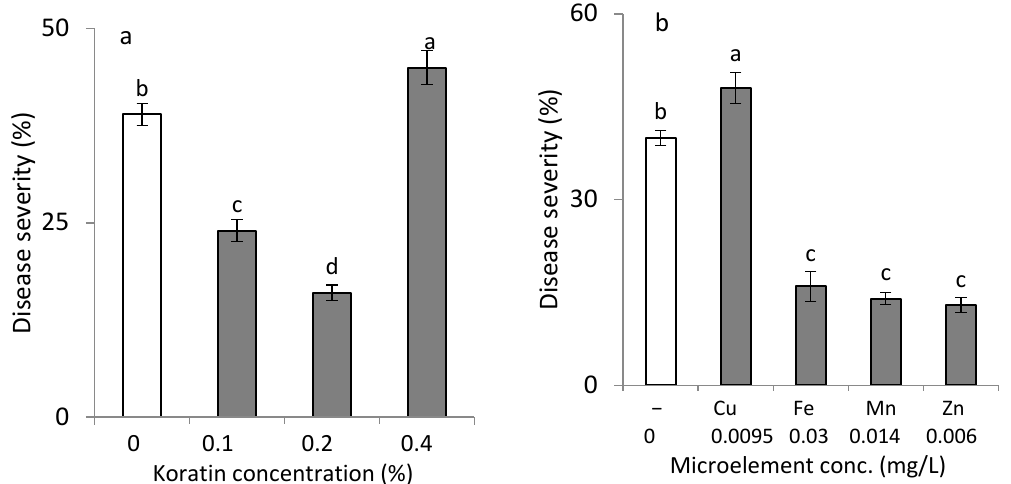
Figure 1. Effects of spray applications of solutions of EDTA chelates of microelements on sweet basil downy mildew (SBDM) severity when applied ( a ) in a mixture or ( b ) as single-microelement solutions. SBDM severity was evaluated on a 0–100% scale, in which 0 = healthy plants and 100% = plants completely covered by disease symptoms. Values followed by a different letter are significantly different according to one-way ANOVA and Tukey’s HSD test. Default significance levels were set at p ≤ 0.05. Bar = SE.